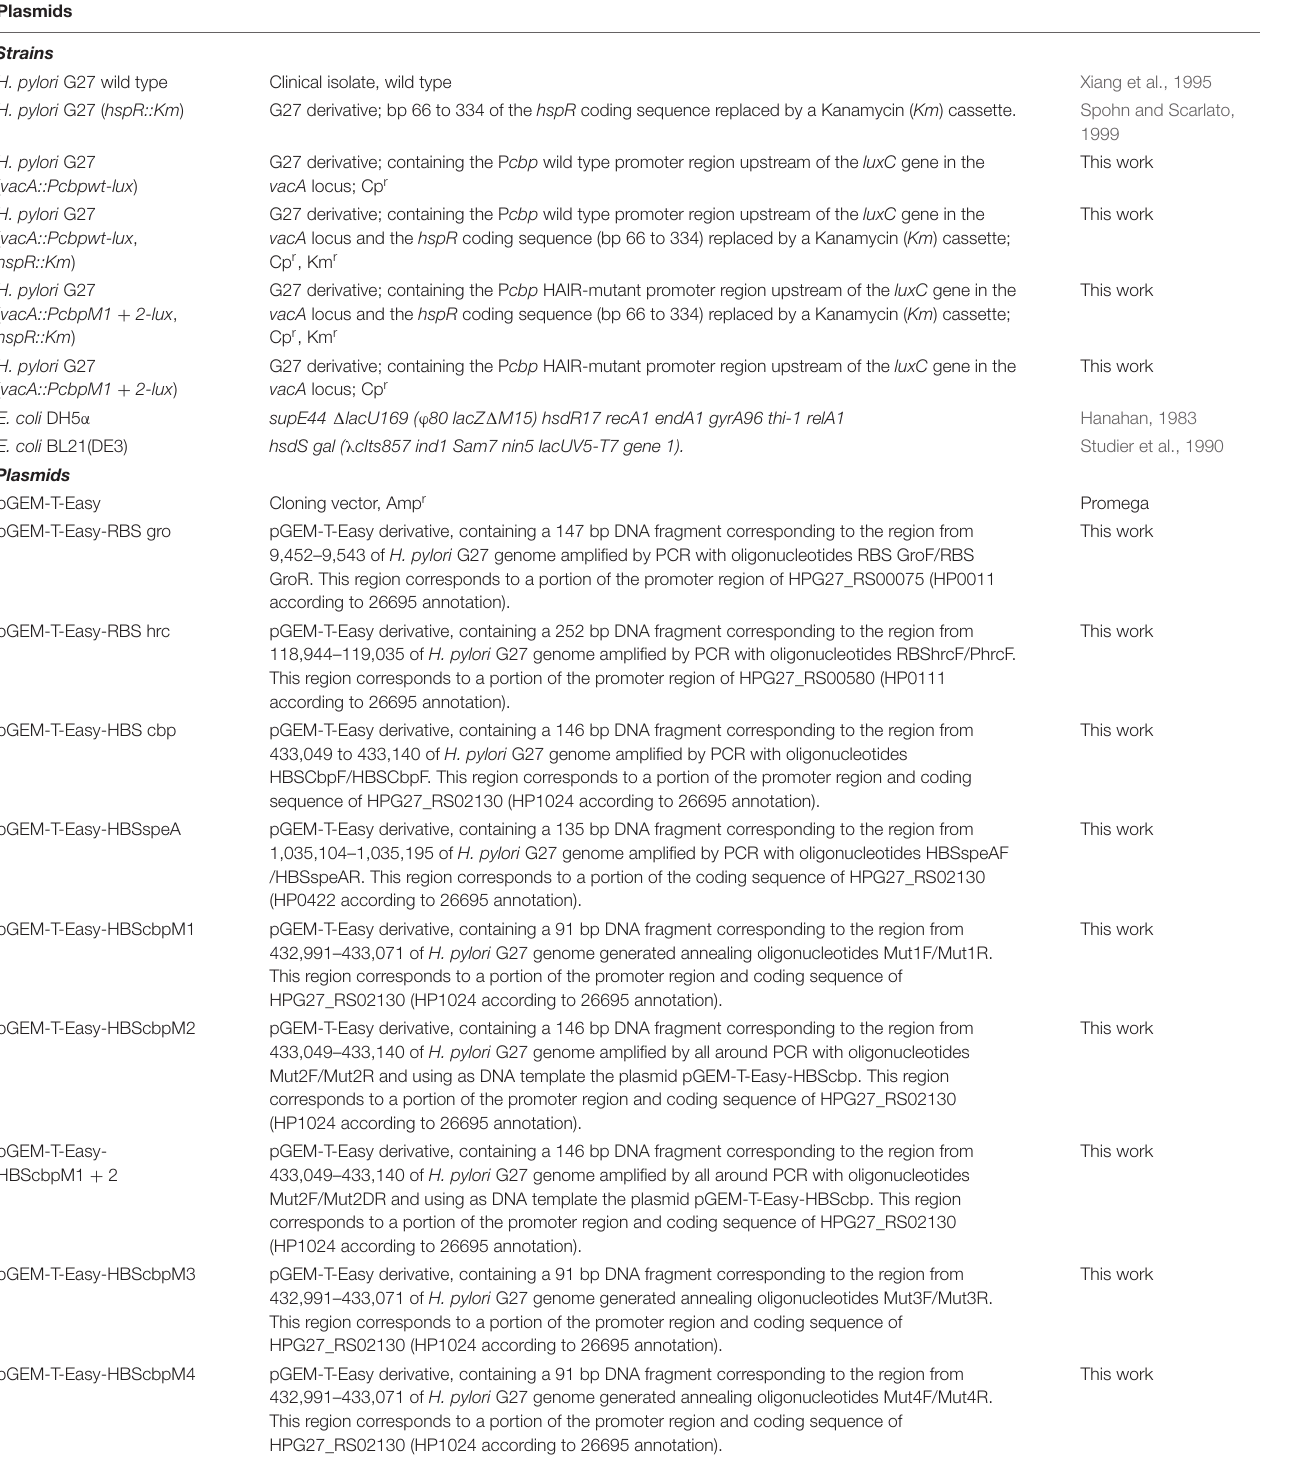
TABLE 1 | Bacterial strains and plasmids used in this